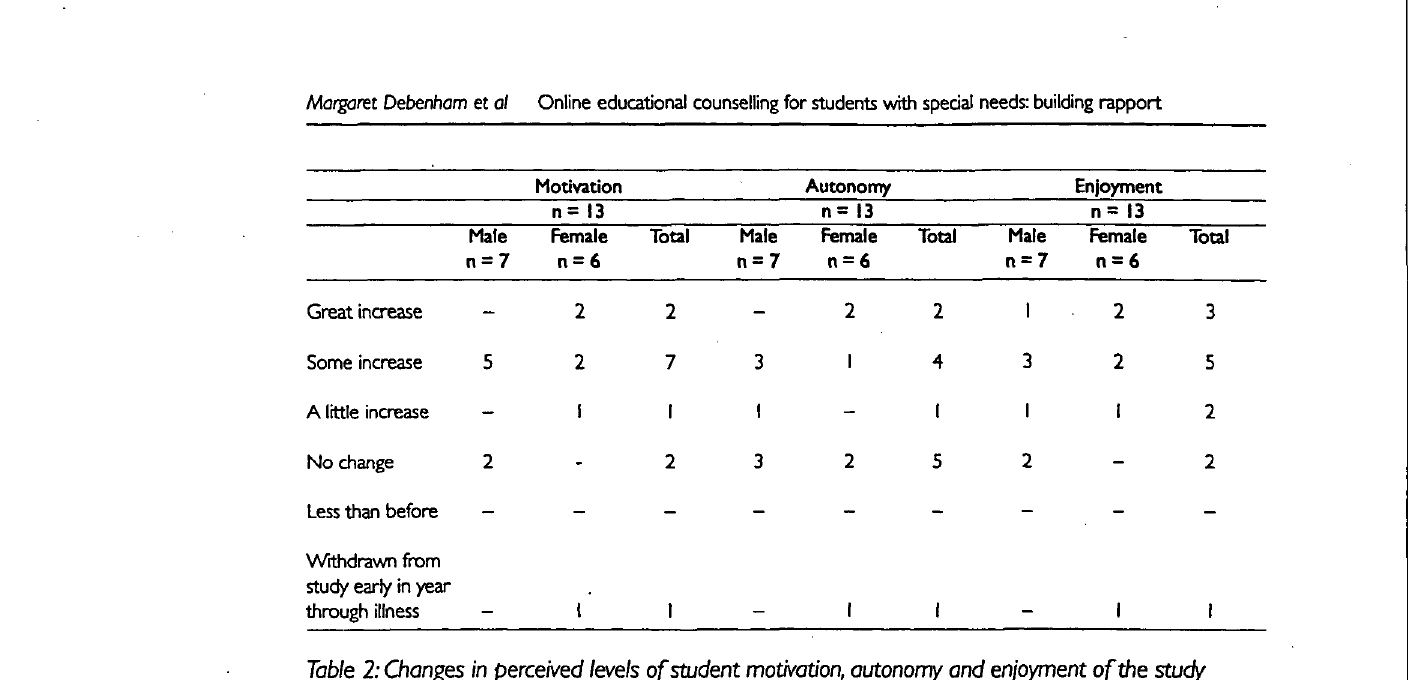
Table 2: Changes in perceived levels of student motivation, autonomy and enjoyment of the study process at conclusion of main